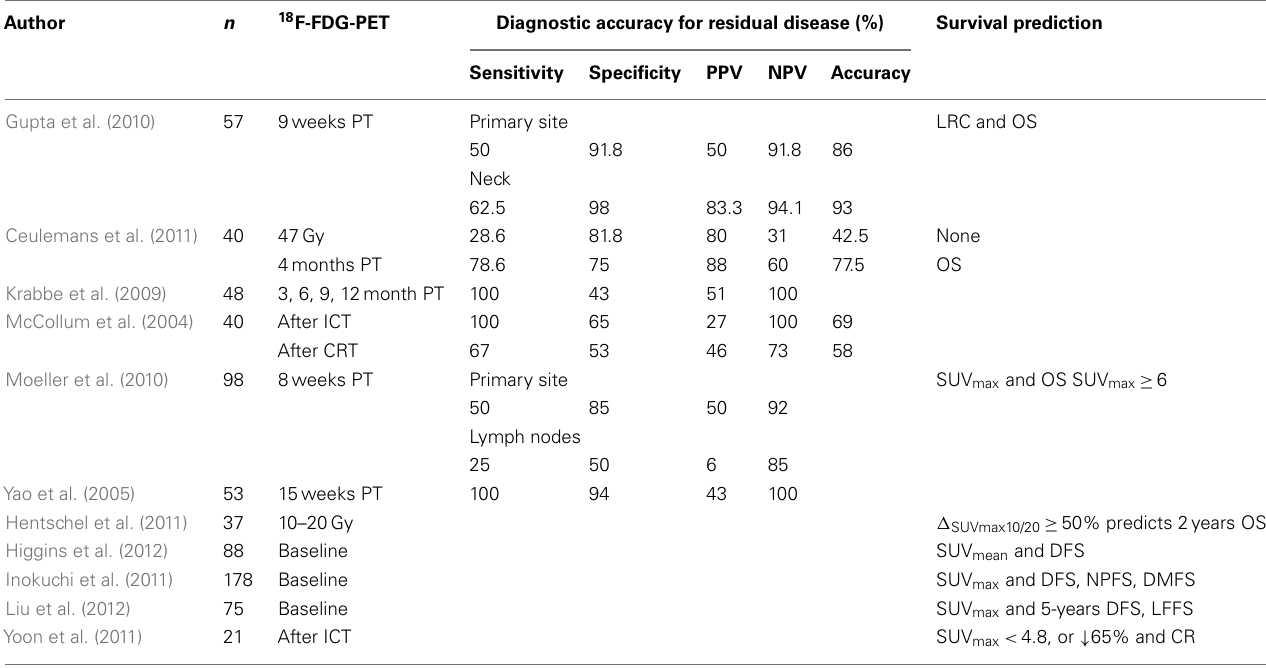
Table 2 | Summary of studies evaluating 18 F-FDG-PET as a predictor of response to CRT in patients with